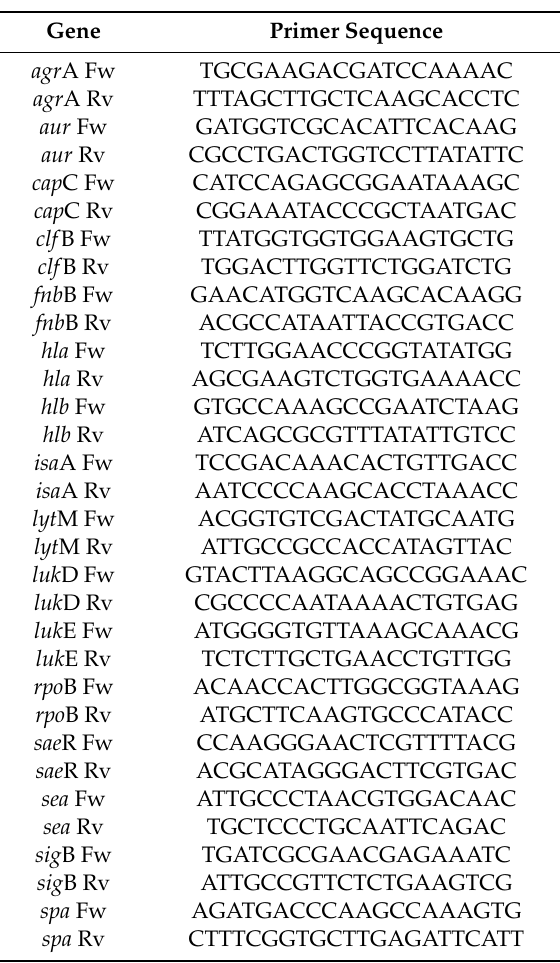
Table 1. Gene target list and oligonucleotide